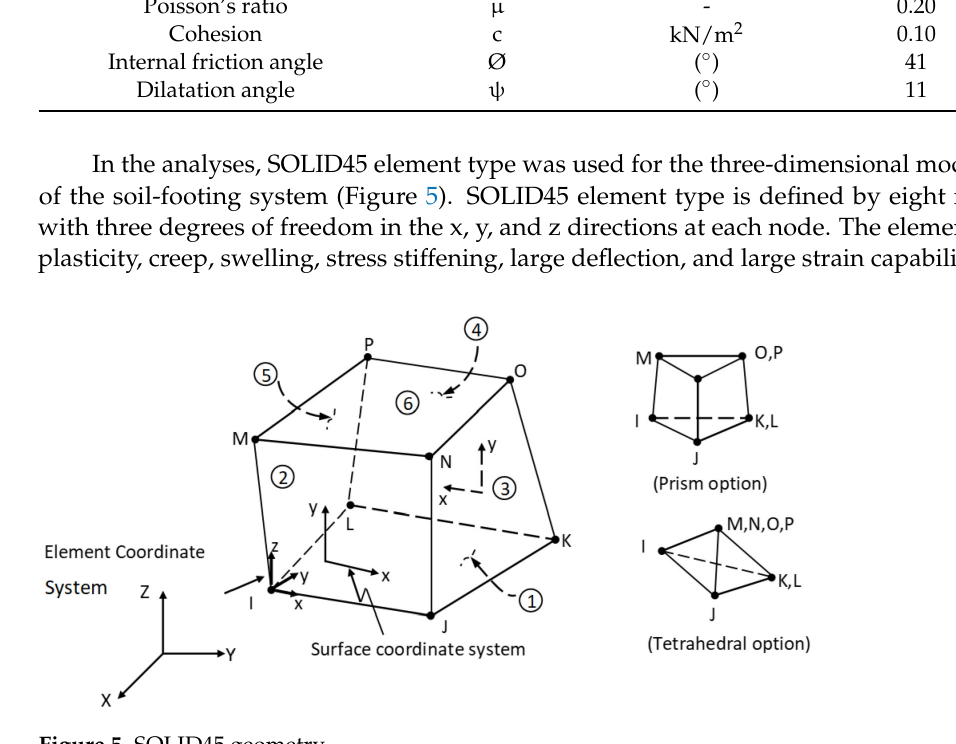
Figure 5. SOLID45 geometry.